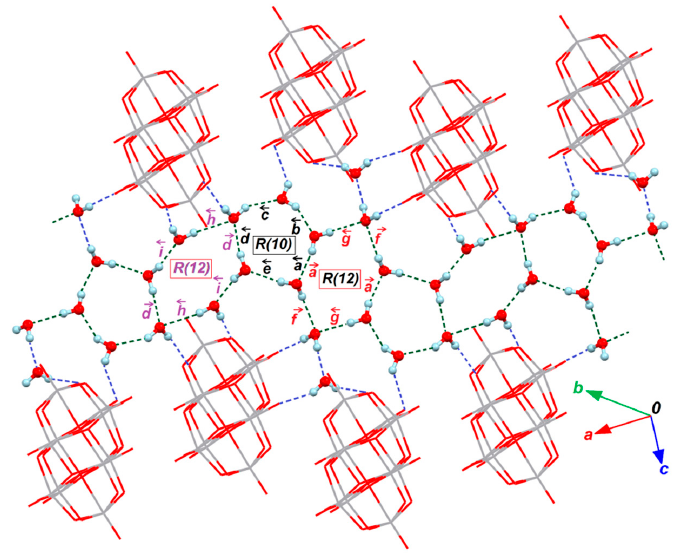
Figure 3. A part of the crystal structure of 2 , omitting cations. The supramolecular network formed by water molecules were based on hydrogen bonds (dashed lines, [27]). Blue H-bonds were used to form the (cid:1829)(cid:4670)(cid:1844)(cid:4666)10(cid:4667)(cid:1844)(cid:4666)12(cid:4667)(cid:4671) backbone, in which (cid:1844) (cid:2873)(cid:2873) (cid:4666)10(cid:4667) and (cid:1844) (cid:2874)(cid:2872) (cid:4666)12(cid:4667) rings alternate. The different types of H-bonds were labeled a ´ i and ring sequences are oriented counter-clockwise. Blue H-bonds connect this backbone to [V 10 O 28 ] 6 − anions in the crystal.